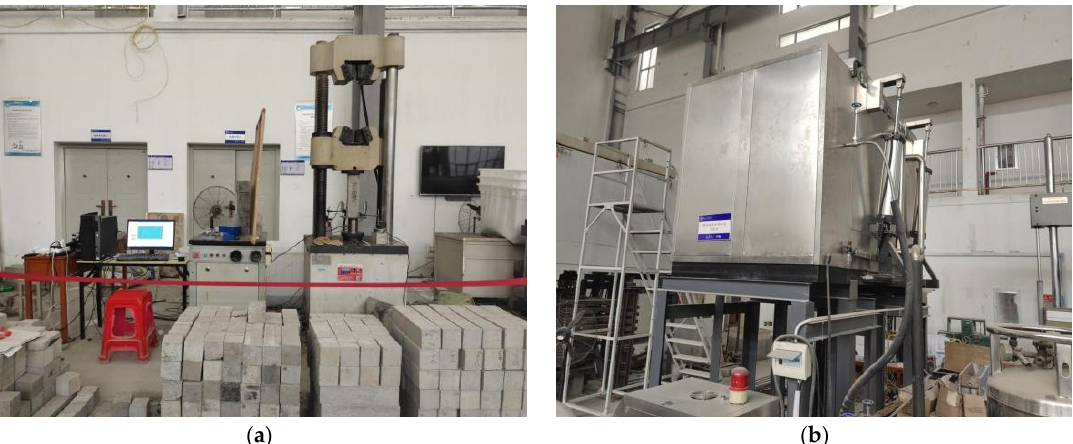
Figure 3. The main equipment of this experiment. ( a ) Mechanical strength test machine. ( b ) Cryogenic freeze–thaw cycle simulation test chamber.